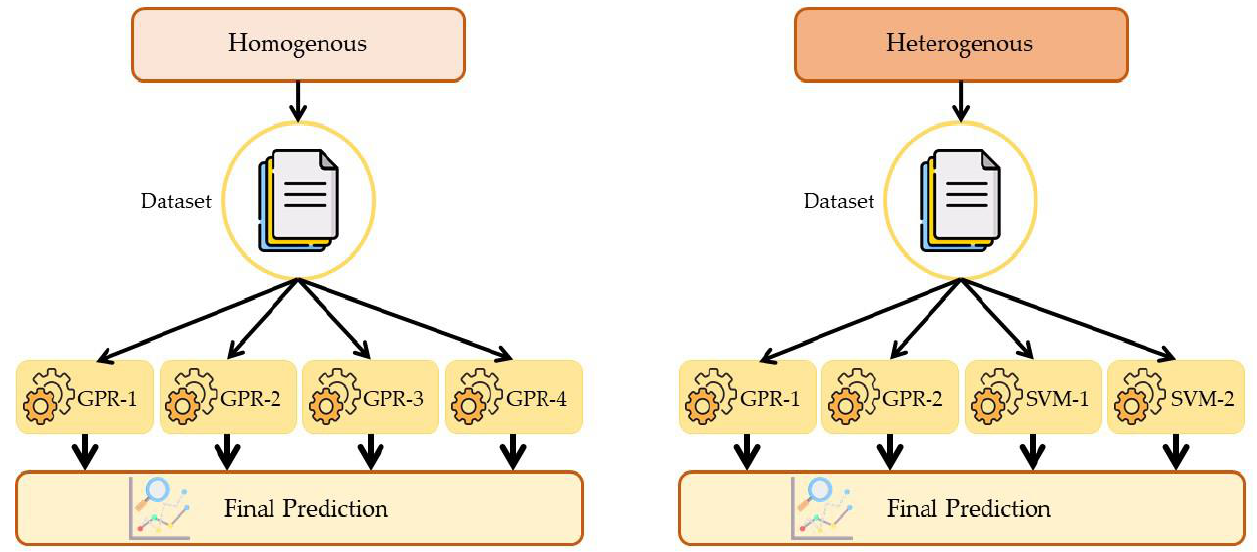
Figure 5. Generic frameworks of the homogenous and heterogenous structures of the EML.